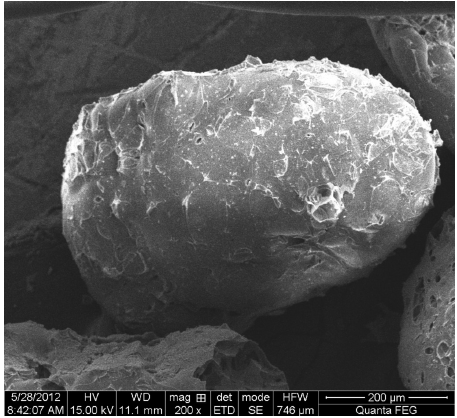
Figure 1 External morphology of glazed hollow beads.